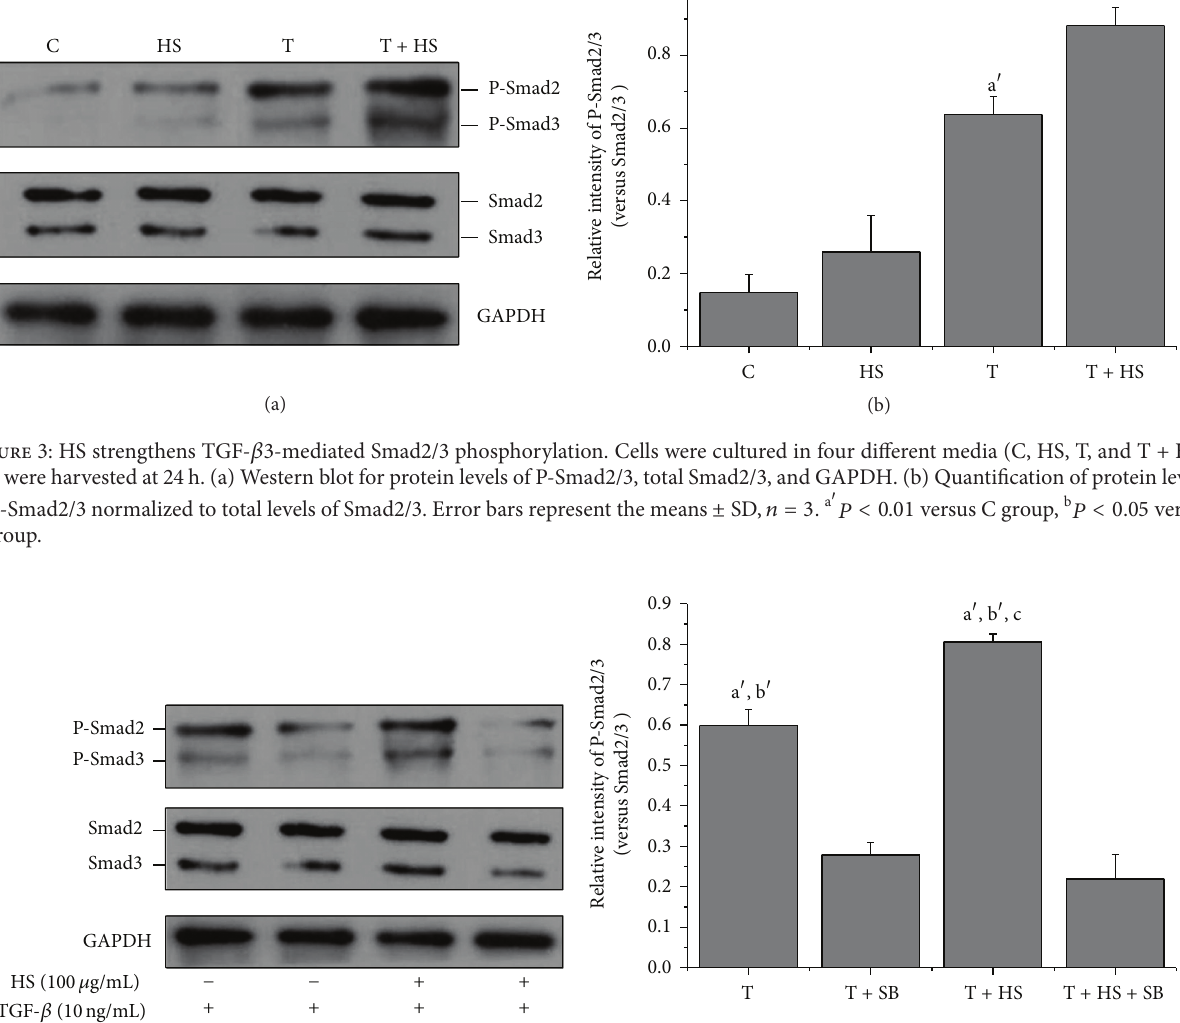
Figure 4: SB431542 blocks HS-activated TGF- 𝛽 3-mediated Smad2/3 phosphorylation. Cells were cultured in control medium supplemented with TGF- 𝛽 3 (T), SB431542 treated for 2 h before treatment with TGF- 𝛽 3 (T + SB), TGF- 𝛽 3 together with HS (T + HS), or SB431542 treated for 2 h before treatment with TGF- 𝛽 3 together with HS (T + HS + SB). Samples were harvested at 24 h. (a) Western blot for protein levels of P-Smad2/3, total Smad2/3, and GAPDH. (b) Quantification of protein levels of P-Smad2/3 normalized to total levels of Smad2/3. Error bars 󸀠 𝑃 < 0.01 󸀠 𝑃 < 0.01 versus T + SB group, b versus T + HS + SB group, and c 𝑃 < 0.05 versus T represent the means ± SD, 𝑛 = 3 . a